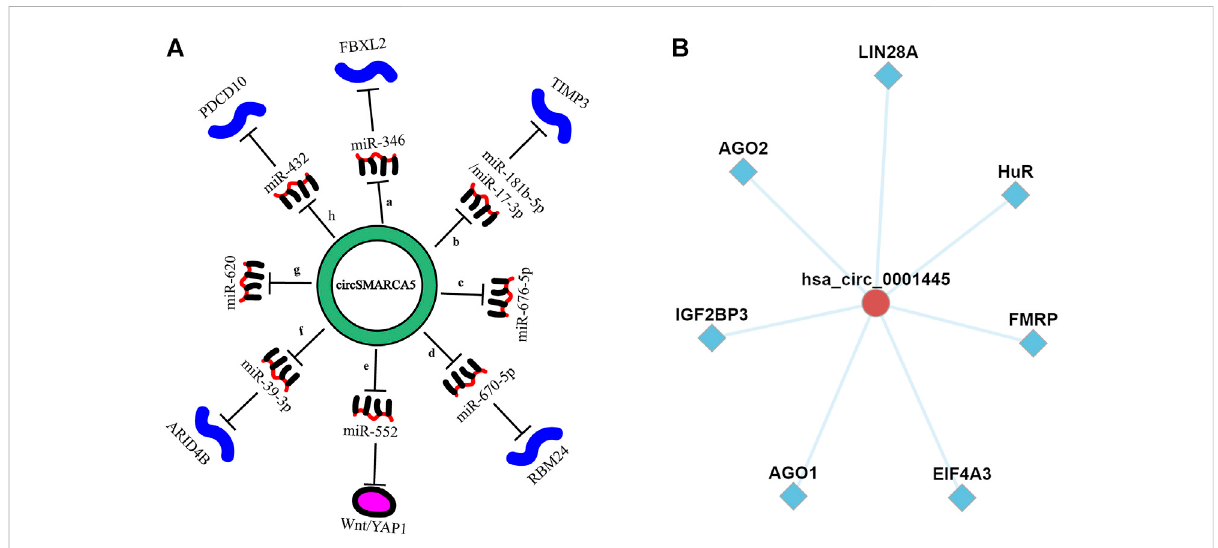
FIGURE 7 (A) .CircSMARCA5 acts as miRNA sponges in various cancers.(a). gastric cancer; (b). hepatocellular carcinoma; (c). non-small -cell lung cancer; (d).multiplemyeloma;(e,f).colorectalcancer;(g).cervicalcancer;(h).prostatecancer. (B) .CircFunBasedatabasewasusedtopredictpotentialRNA- binding proteins that can bind to